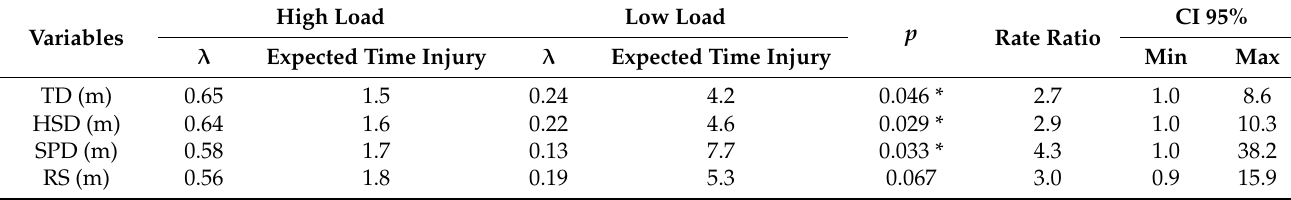
Table 4. Relationship between injuries and different levels of load to find the expected time until new injuries (mean).